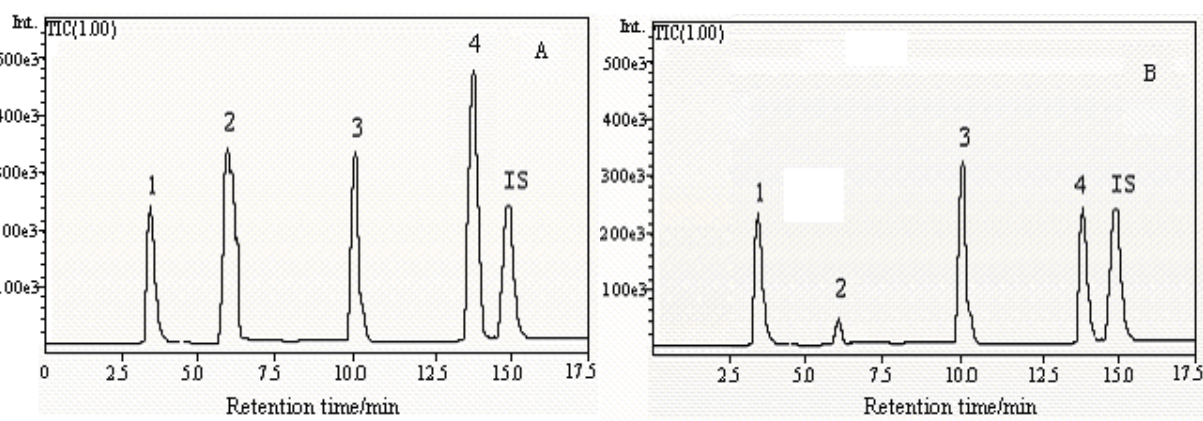
Figure 3. LC/ESI-MS total ion chromatograms (TIC) of nucleoside standards: (A) and water extracts of Cordyceps sinensis from Qinghai Province (B) (1) thymine; (2) adenine; (3) adenosine; (4) cordycepin; (5) 2-chloroadenosine.The concentration of each standard and 2-chloroadenosine was 10 µg·mL -1 .